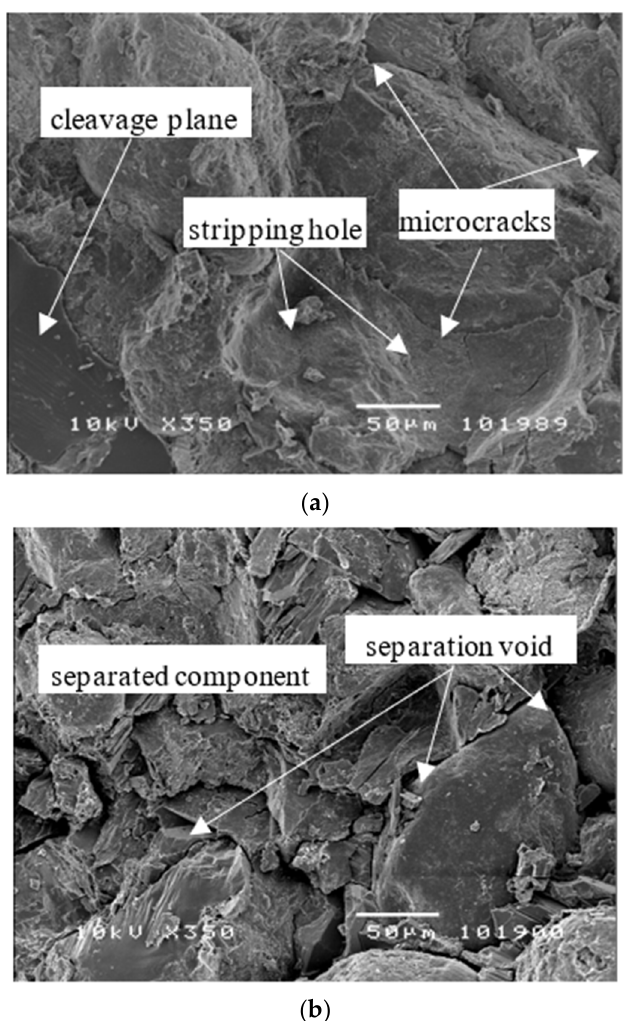
Figure 8. Local microscopic fracture morphology. ( a ) − 40 °C red sandstone, ×350, ( b ) − 30 °C red sandstone, ×350.